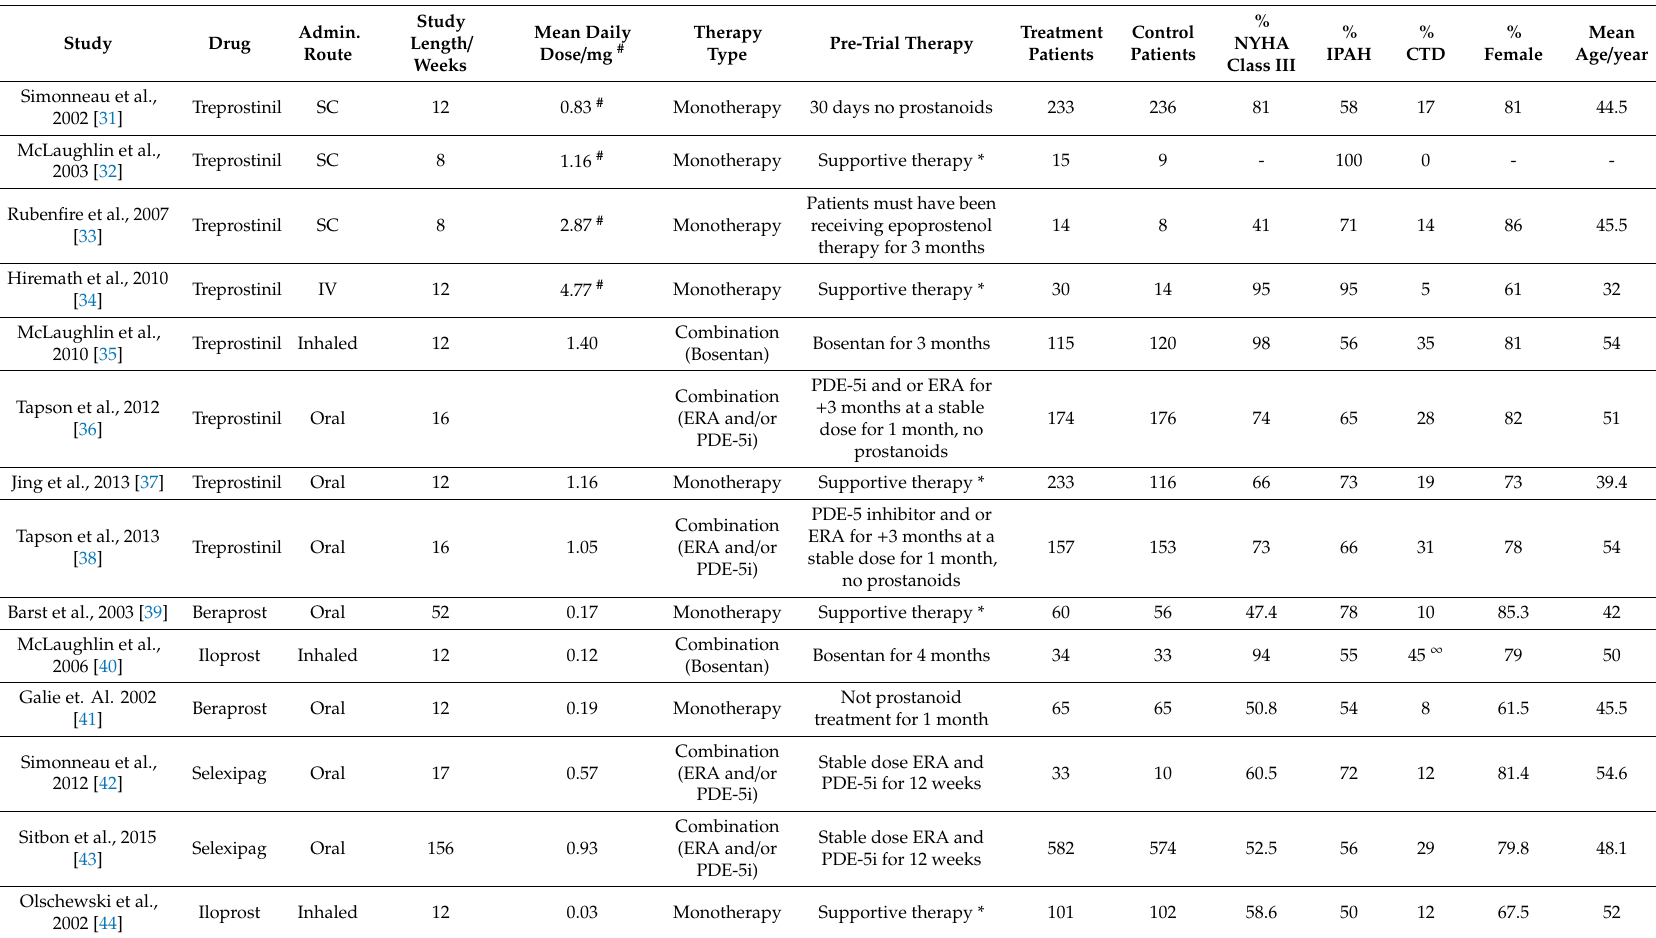
Table 1. Summary of clinical trials involving prostacyclin mimetics compared against